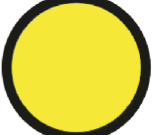
Figure 4: A yellow circle needed to be clicked by the user (various sizes and